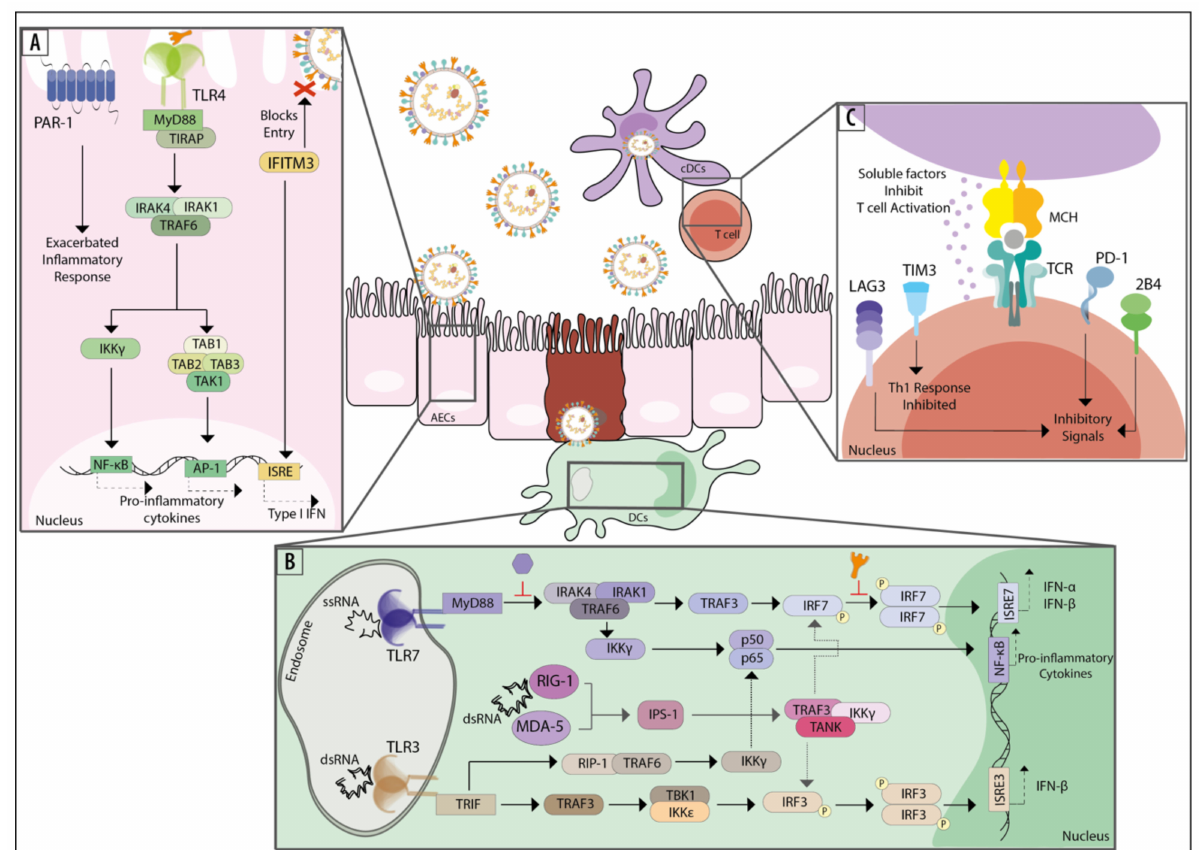
Figure 2. Molecular components of the host contributing to the modulation of the immune response during human metapneumovirus (hMPV) infection. ( A ) Zooming into an airway epithelial cell (AEC), the different mechanisms responsible for modulating the antiviral response against hMPV can be found. The protease-activated receptor 1 (PAR-1) exacerbates the inflammatory response. The interferon-induced transmembrane (IFITM) proteins prevent the entry of the virus into the cell while also promoting the secretion of type I IFN. Additionally, Toll-like receptor (TLR) 4 promotes the secretion of proinflammatory cytokines. ( B ) Zooming into a cell from the innate immune response, such as a dendritic cell (DC), several pattern recognition receptors (PRRs) and modulatory molecules can be found. TLR7 and TLR3 are expressed inside these DCs (within the endosomes), and these receptors recognize ssRNA and dsRNA, respectively. TLR7 induces the secretion of type I IFN (IFN- α and IFN- β ) and NF- κ B, while TLR3 promotes the expression of IFN- β and NF- κ B. Retinoic acid-inducible gene I (RIG-I) and melanoma differentiation-associated gene 5 (MDA5) can be found in the cytosol, which induce the secretion of IFN- α and IFN- β upon recognition of dsRNA. ( C ) Zooming into a cell from the adaptive immune response, such as a T lymphocyte, the different receptors and modulatory mechanisms associated with T cell activation can be found. An impaired T-lymphocyte activation has been described when these cells are cocultured with hMPV-infected DCs. The inhibitory receptors programmed death 1 (PD-1), LAG3, and 2B4 will induce an anergic state in these T lymphocytes. T-cell immunoglobulin and mucin-domain containing-3 (TIM3) impairs the activation of the T helper 1 (Th1) signaling pathway, a response that is especially suited to fighting viral